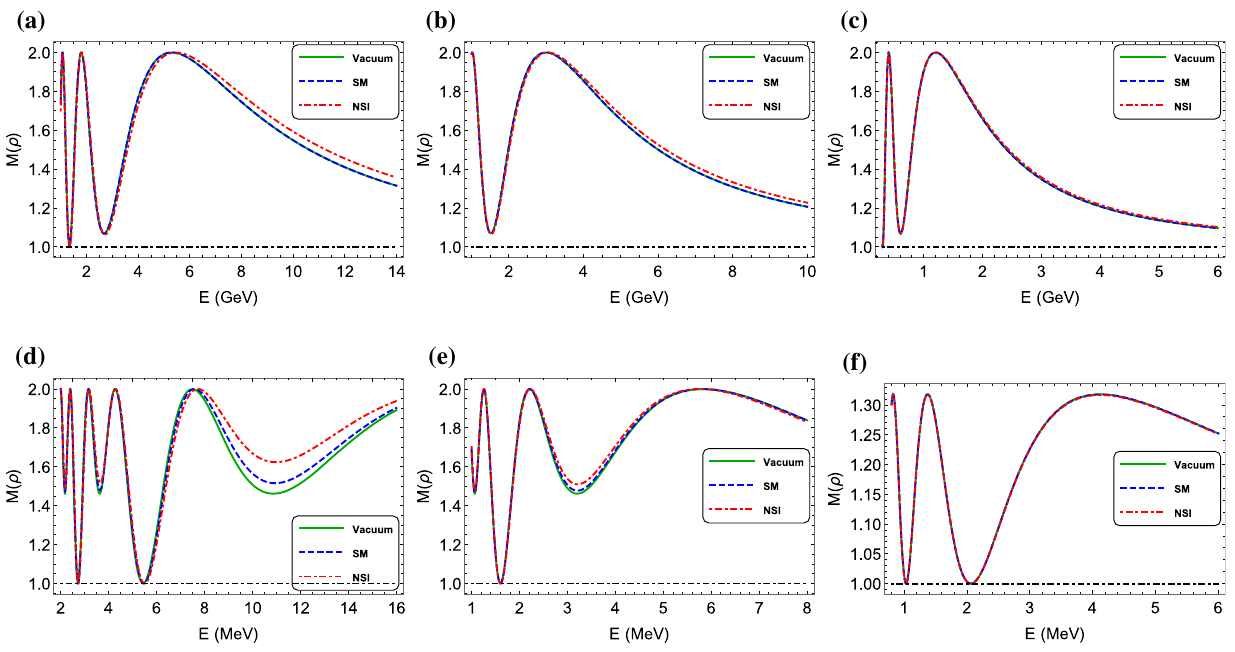
Fig. 1 Variation of M( ρ ) with energy ( E ) for the accelerator and reac- tor experiments: a upper left: DUNE, L = 1300 km, E ≈ 1 − 14 GeV; b upper middle: MINOS, L = 735 km, E ≈ 1 − 10 GeV; c upper right: T2K, L = 295 km, E ≈ 0 − 6 GeV; d lower left: KamLAND, L = 180 km, E ≈ 1 − 16 MeV; and e lower middle: JUNO, L = 53